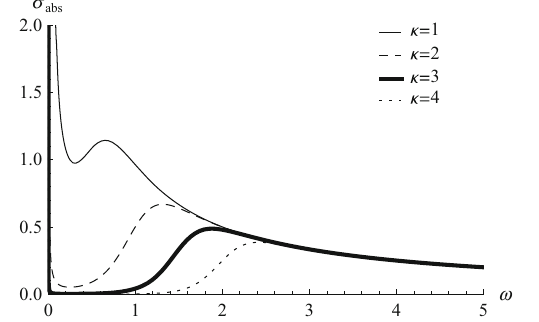
Fig. 2 Thereflectioncoefficient R ( solidcurve ),thetransmissioncoef- ficient T ( dashed curve ), R + T ( thick curve ), and the absorption cross section σ abs ( dotted curve ) as a function of ω ; for κ = 1 and r + = 1